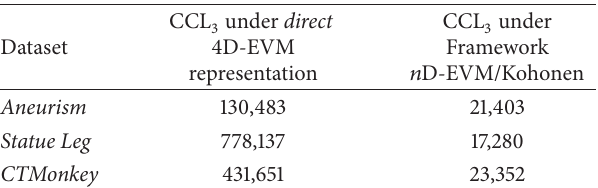
Table 18: Global errors’ comparisons for representation of volume datasets (see text for